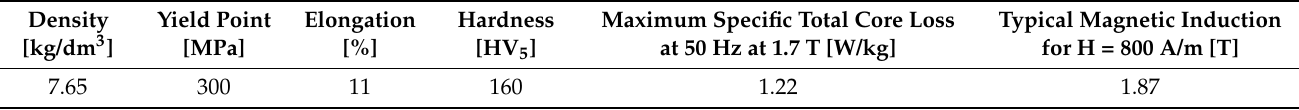
Table 1. Mechanical and magnetic properties of ET 122-30 steel (at T = 20 ◦